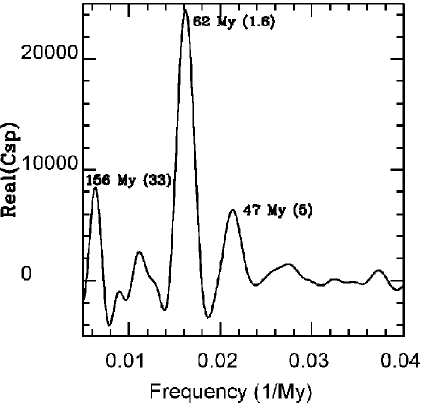
Figure 3. The real part of the complex cross-spectrum of the Sepkoski data with the Paleobiology Database. This is a measure of the combined significance of the same frequency in both datasets, with the same phase angles, so that the peaks coincide. The inset numbers give the period corresponding to the shown frequency peak. The number in parentheses is the mismatch, in My, between the peaks in one set versus the other. The 62 My cycle dominates the figure and has excellent phase agreement between the two